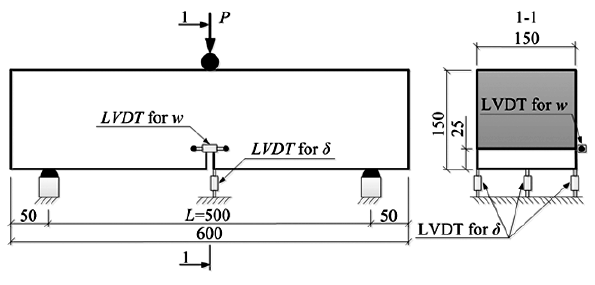
Fig. 4. The test set-up beams were loaded with the rate of 0.2 mm/min. To loca- lize cracking process, each beam was equipped